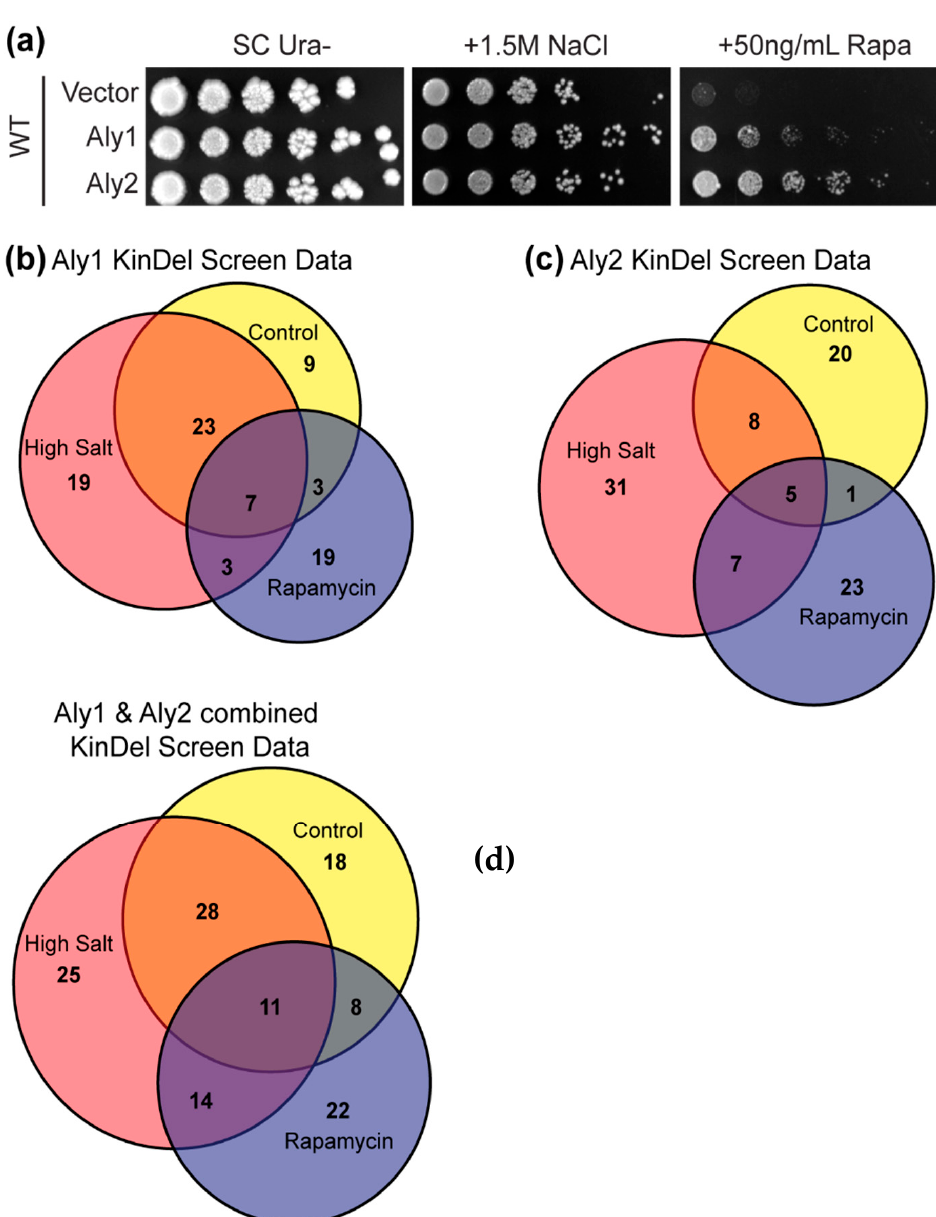
Figure 1. KinDel candidates that influence α -arrestin-dependent phenotypes: ( a ) Growth of serial dilutions of WT cells containing the indicated pRS426-derived plasmids expressing either nothing (vector) or the indicated α -arrestin on SC medium lacking uracil and containing 1.5M NaCl or 50 ng/mL rapamycin. ( b – d ) Venn diagrams indicating the number of KinDel library gen deletions found to alter the sensitivity of ( b ) Aly1 or ( c ) Aly2 on control (yellow), high-salt (red), or rapamycin (blue) medium. The sum of the numbers in each circle identifies the number of gene deletions in each class. Panel ( d ) shows the overlapping candidates identified in both the Aly1 and Aly2 screens for each medium condition.